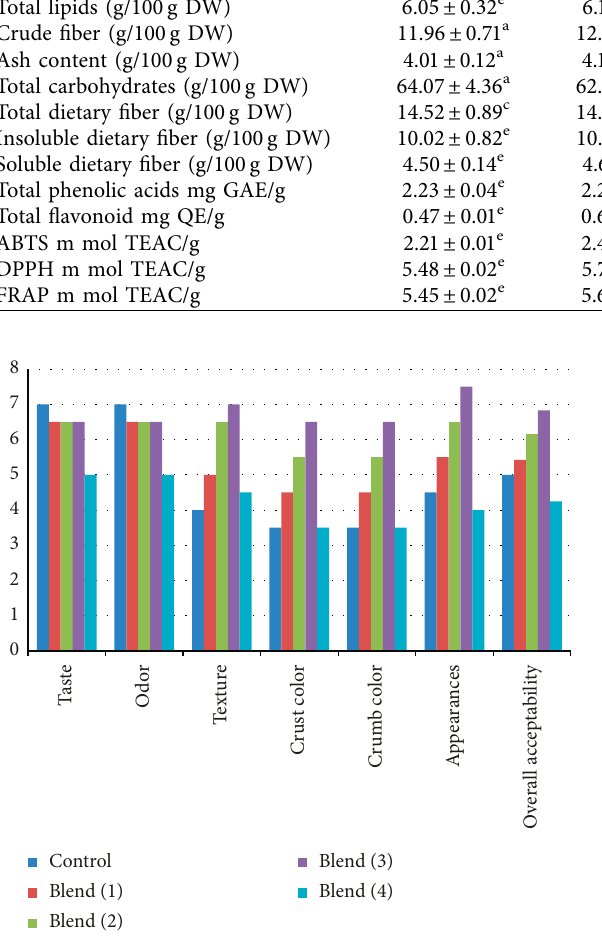
Figure 3: Sensory properties of pan bread blends.